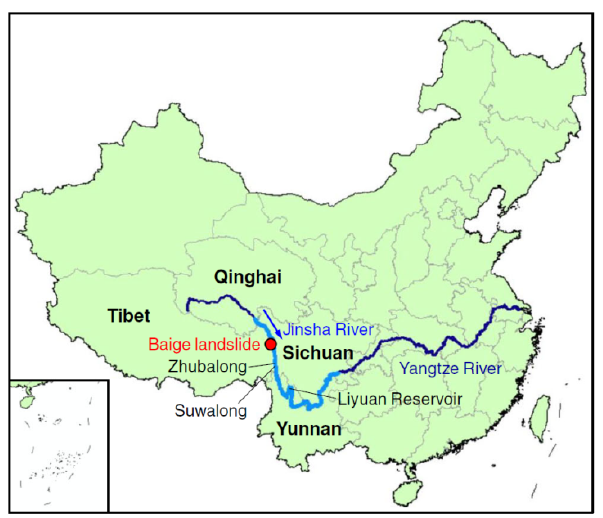
Figure 3. Location of Baige landslide. The figure comes from Zhang et al. (2019) [9].